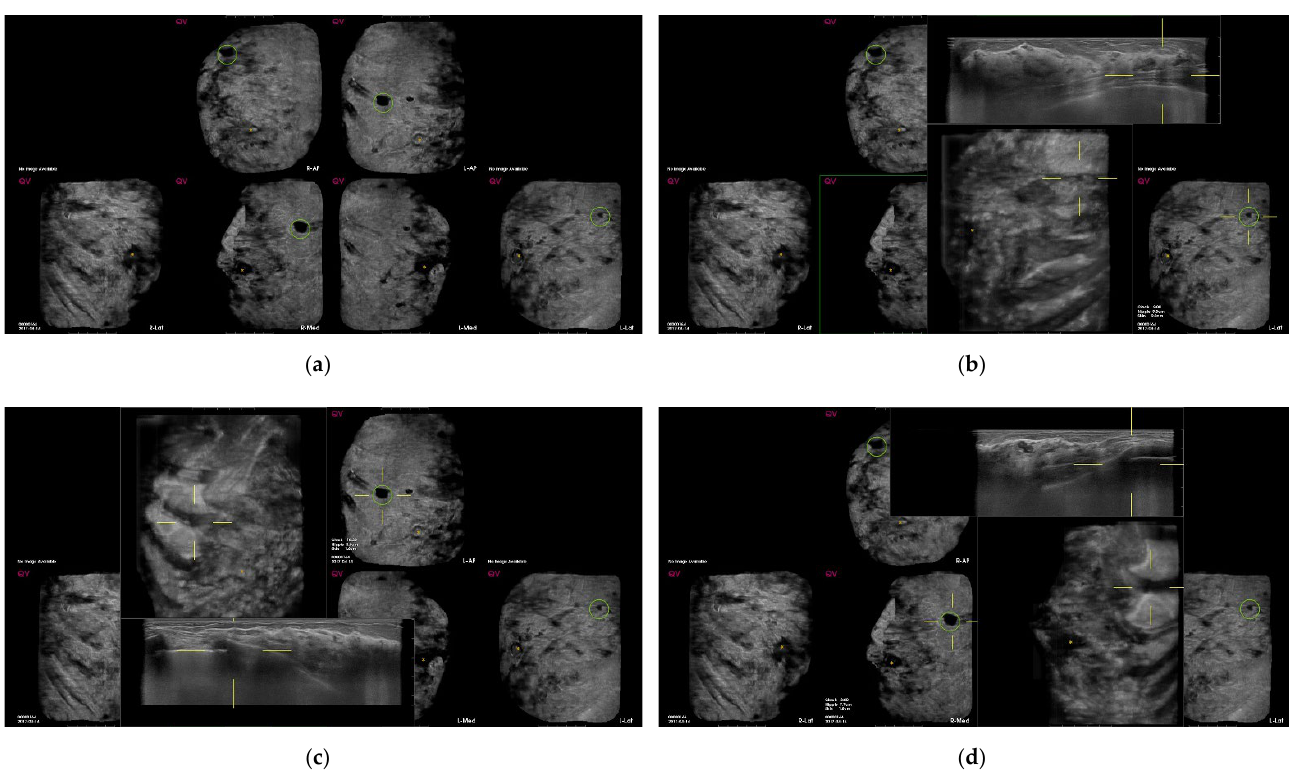
Figure 3. Screening automated breast ultrasound (ABUS) of a 42-year-old woman shows false-positive marks due to rib. ( a ) CAD-based minimum-intensity projection (MinIP) of an ABUS scan in the AP, medial, and lateral sides of both breasts. There are four dark spots with green circles. ( b – d ) The lesions showing dark spots with green circles in both AP and right medial sides of both breasts confirm pseudolesions due to ribs in the transverse scan.